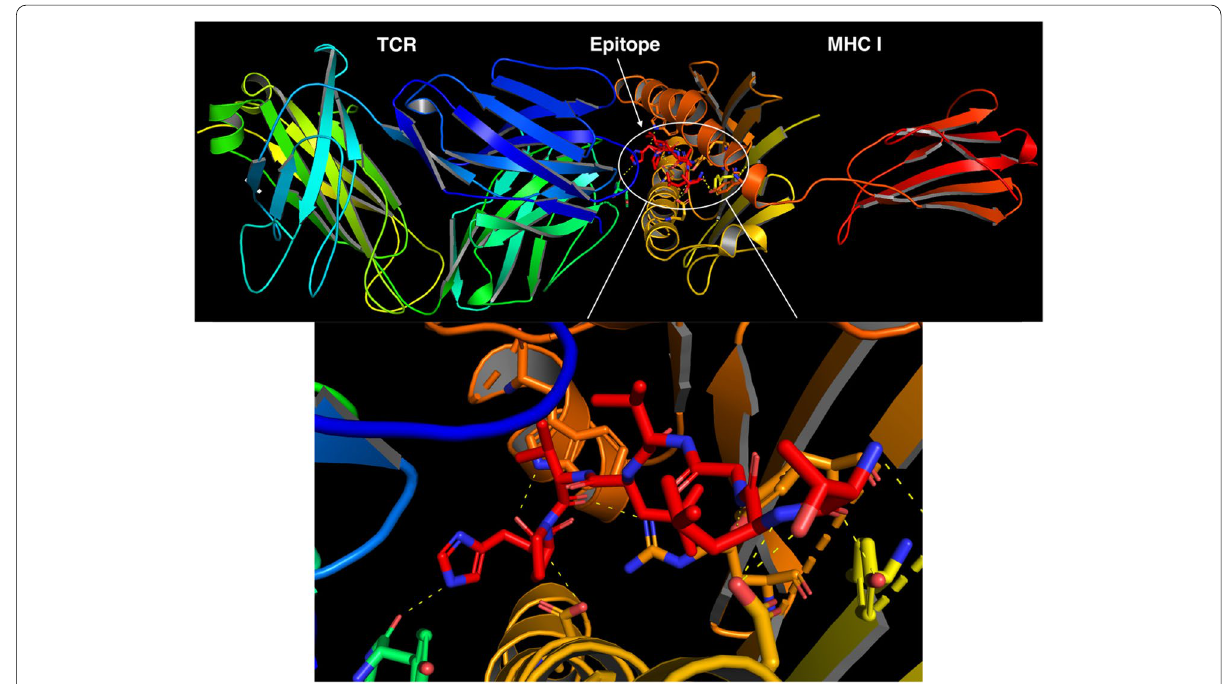
Fig. 5 Molecular docking of ORF1ab epitope (No. 79 in Table 1) with both 5yxn MHC I molecule and TCR